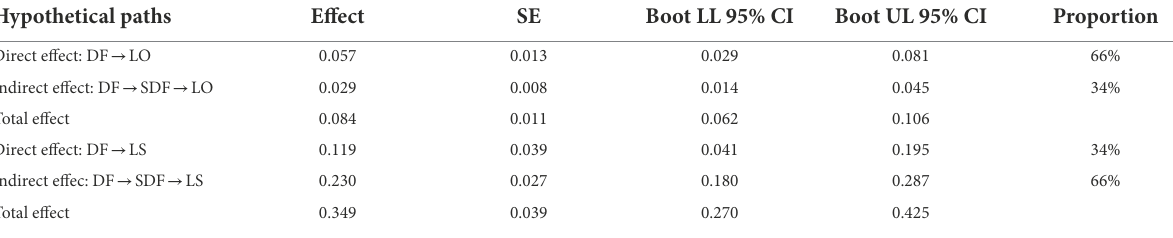
TABLE 4 Results of mediation effect test.